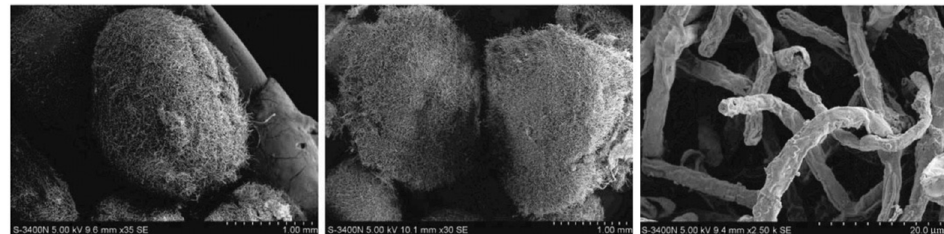
Figure 2. SEM images of the outer surface and interior of filamentous-type AGS. Adapted from reference [22] (copyright reserved Elsevier, 2010).